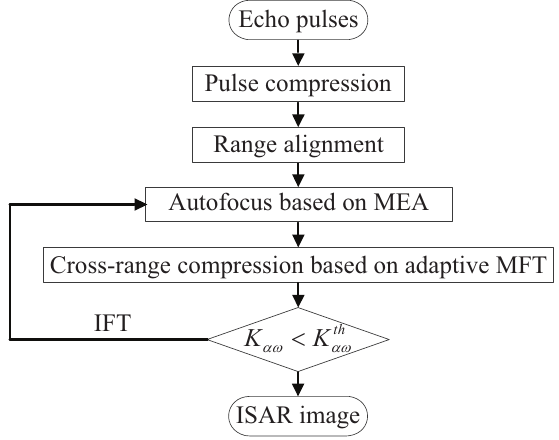
Figure 3. Flowchart of the new imaging